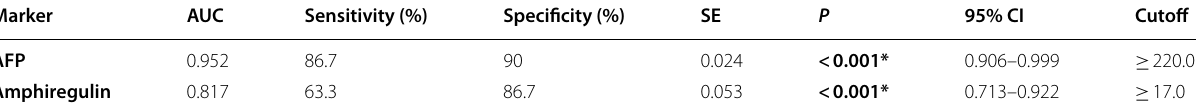
AUC Area under curve, SE Standard error, CI Confidence interval *Significant